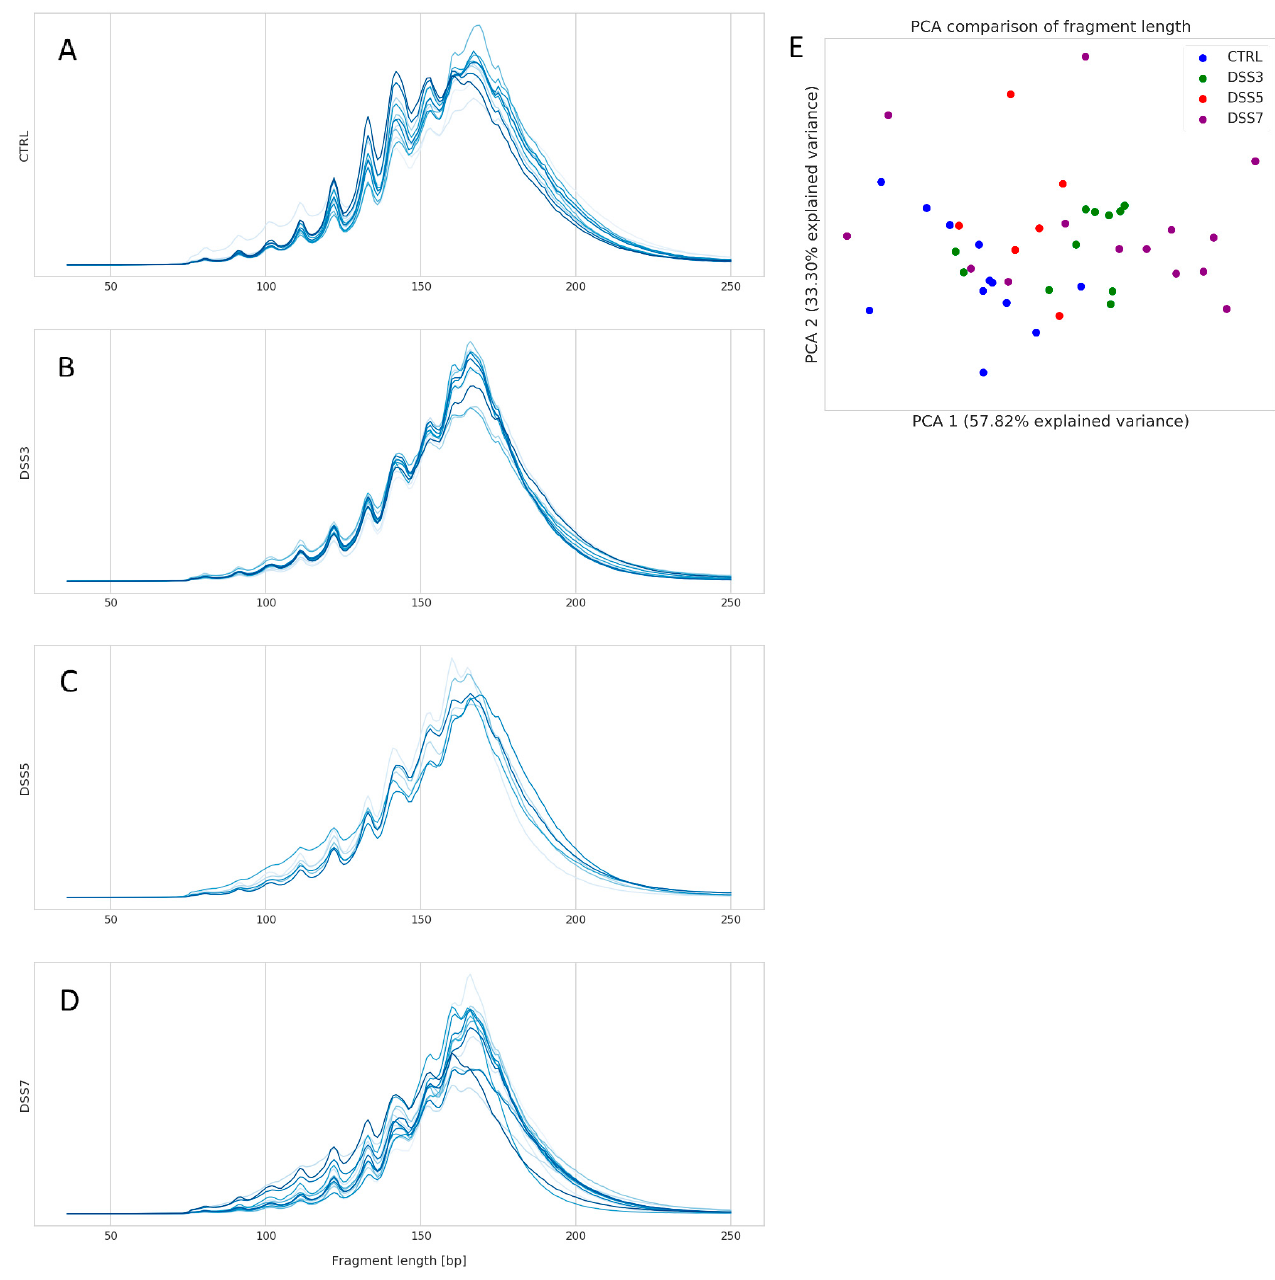
Figure 4. Distribution of ecDNA fragments. Size and relative abundance of plasma ecDNA fragments in ( A ) CTRL, ( B ) DSS3, ( C ) DSS5 and ( D ) DSS7. CTRL shows higher abundance of fragment size 120–160 bp compared with other groups. Intragroup variability in the number of specific fragment sizes rises from CTRL towards DSS7 group. DSS7 showed the highest variability of fragment sizes and relative abundance. ( E ) principal component analysis (PCA) comparison of fragment sizes shows that the groups do not form bordered clusters. However, a clear left-to-right trend on x -axis is obvious from CTRL to DSS7 group.